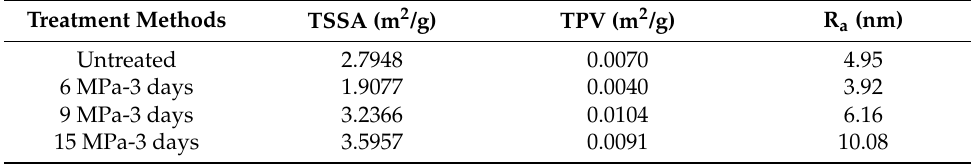
Table 1. N 2 GA test results of shale